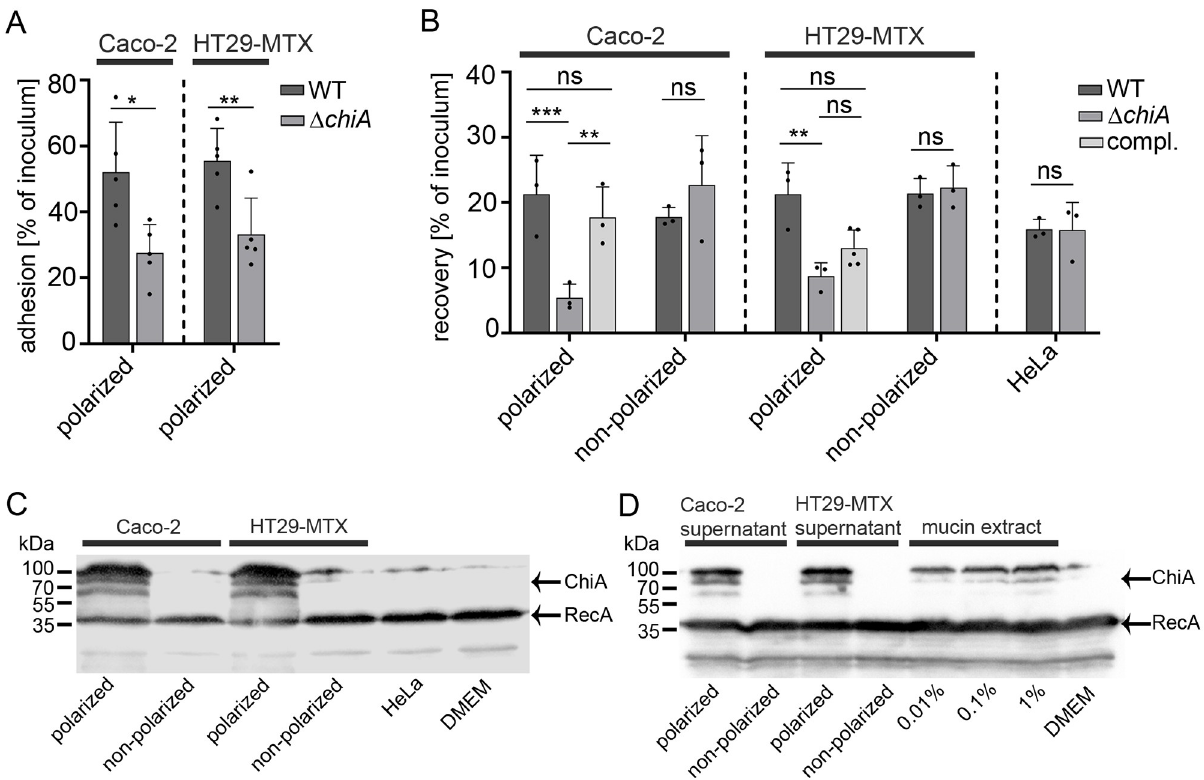
Fig 1. S . Typhimurium ChiA contributes to polarized IEC adhesion/invasion and is strongly induced upon contact with polarized IEC, polarized supernatants and mucin extracts. (A) Adhesion assay with S . Typhimurium wild-type and Δ chiA mutant in contact with polarized Caco-2 and HT29-MTX cells. Statistical analysis of adhesion versus inoculum (ratio) between conditions with unpaired student´s t-test. P > 0.05: ns; P � 0.05: * ; P � 0.01: ** . (B) Recovery counts of S . Typhimurium WT, Δ chiA mutant, and complemented Δ chiA mutant strain after invasion assay (gentamycin treatment) in polarized and non-polarized Caco-2 cells, HT29-MTX cells, and HeLa cells. Counts of invaded bacteria were compared to inoculum (ratio) for each condition. Statistical analysis was implemented with ordinary one-way ANOVA and Bonferroni´s multiple comparison test P > 0.05: ns; P � 0.05: * . (C) Expression analysis by Western blot of S . Typhimurium, carrying chromosomally encoded 3xFLAG tagged ChiA and plasmid pTG0069 (RecA-3xFLAG), after 3 h in contact with polarized and non-polarized Caco-2, HT29-MTX cells, and HeLa cells. The protein mass of ChiA is 79.3 kDa which also includes the C-terminal 3xFLAG tag. Hence, ChiA is arrow marked at about 80 kDa. The two additional protein bands at 60 and 100 kDa are unknown and indicate an aberrant migration behavior of ChiA on SDS-PAGE. RecA was used as a loading control. (D) The same strain as described before was used to detect ChiA expression after 3 h incubation of the bacteria in filtered (0.45 μ m filter) cell-free supernatants of polarized and non- polarized IEC, or in a porcine stomach mucin extract (Sigma) of different concentrations as indicated in the figure.